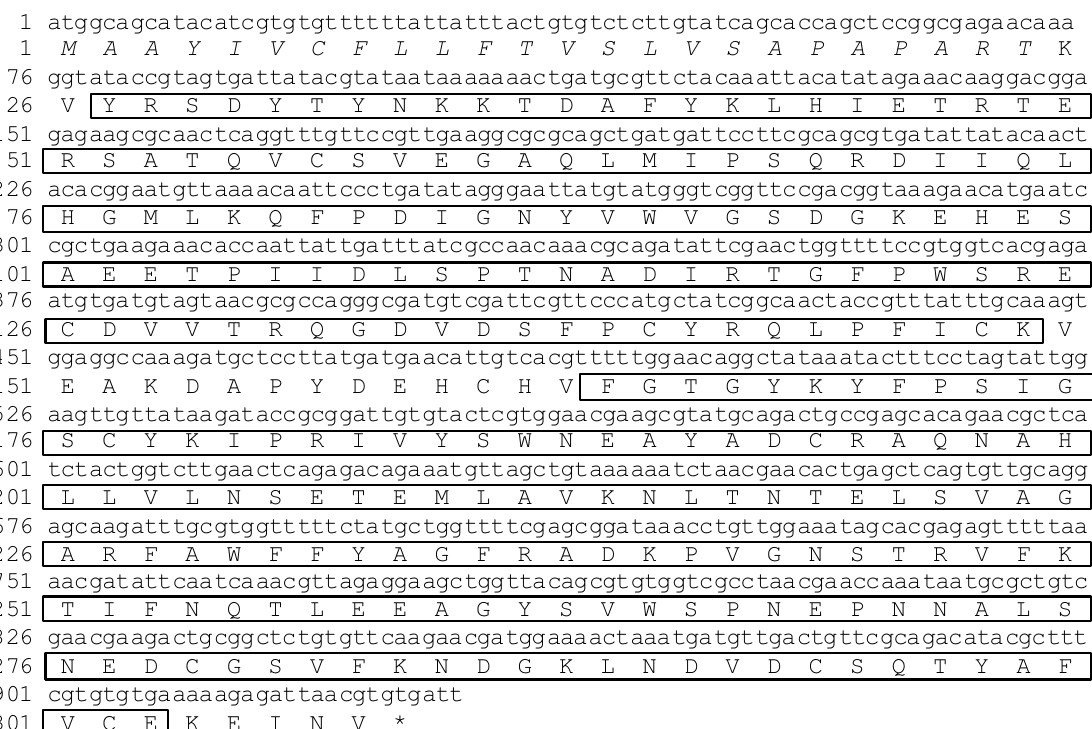
Figure 3. Nucleotide and amino acid sequences of ApCTL1. Italic amino acids indicate the signal peptide and the two sets of boxed amino acids indicate carbohydrate recognition